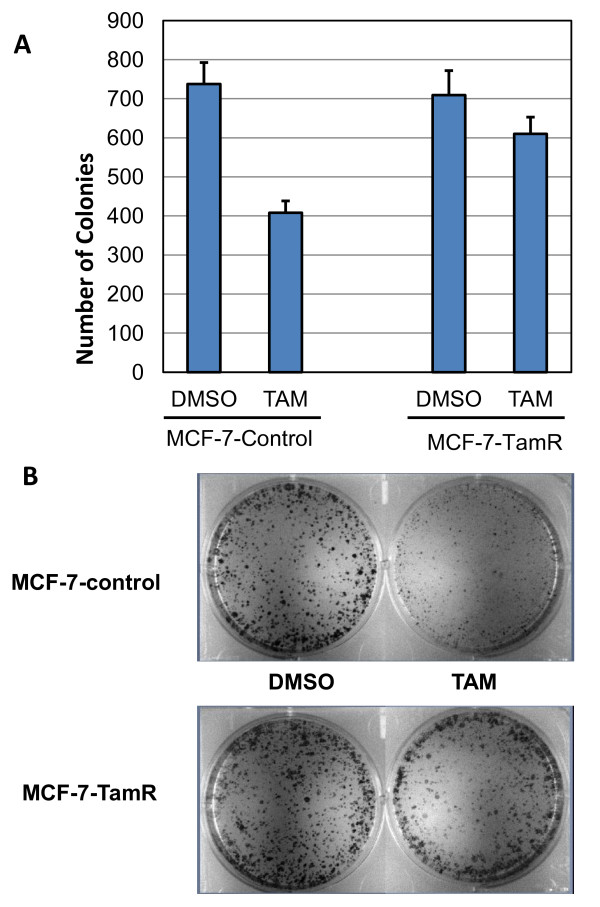
MCF-7-TamR cells are resistant to tamoxifen in clonogenic assays. A. Effect of tamoxifen on colony formation of MCF-7-TamR and MCF-7-control. Number of colonies formed in resistant and sensitive cell lines was plotted as a function of treatment (DMSO and tamoxifen). B. Representative colony images of the resistant and sensitive cells.